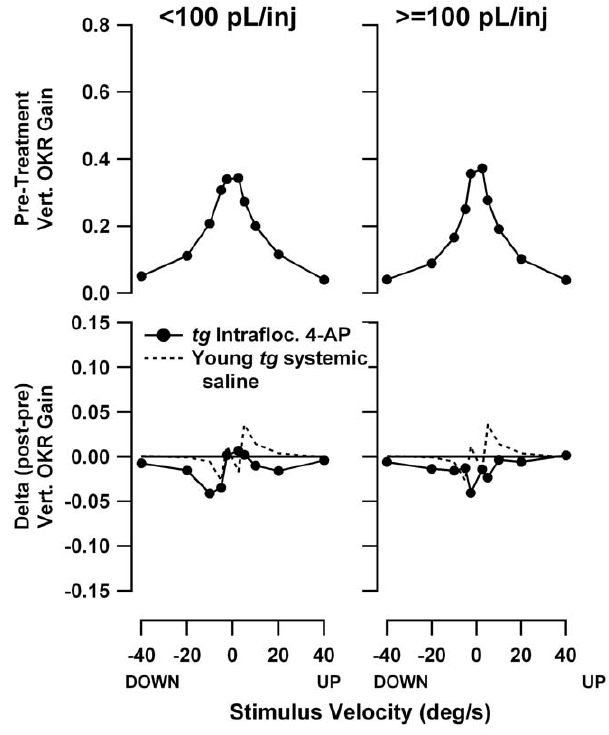
Figure 12. Effect of 4-AP on yaw OKR speed tuning, following low-volume ( , 100 pL/injection, left panels) and high-volume ( . 100 pL/injection, right panels) intrafloccular injections. Format of graphs is identical to Figures 6 and 7. In the gain change plots (bottom plots), the gain change curve for the systemic saline sessions of young tottering from Figure 6 has been superimposed for reference (dashed line). The gain change curves for the 4-AP intrafloccular injections and systemic saline do not differ, or do not differ according to the volume of injected 4-AP, suggesting the lack of any drug effect.